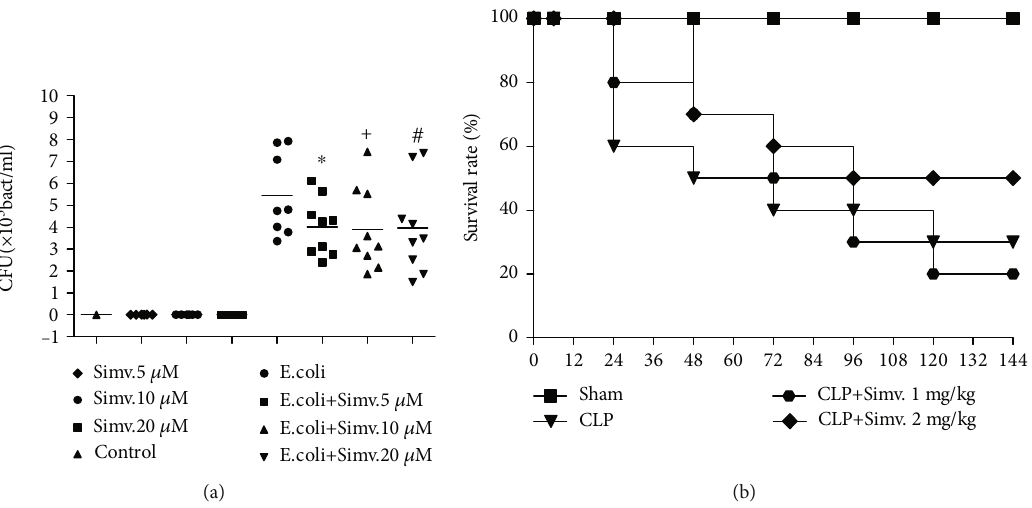
Figure 9: E ff ect of simvastatin in bacterial elimination by peritoneal macrophages stimulated with E. coli and on mortality of animals submitted to CLP. Peritoneal macrophages were pretreated with simvastatin (5 μ M, 10 μ M, 20 μ M), and after 1 hour, they were stimulated with E. coli (a). After 30 minutes, the culture supernatants were plated for CFU counting. SW mice were treated with simvastatin (1 mg/kg and 2 mg/kg) 6 hours after surgery. The mortality was observed for 7 days after sepsis induction (b). Data represented as mean ± SEM of at least 6 animals. ∗ p < 0 : 05 , control vs. CLP+vehicle, # p < 0 : 05 , CLP+ vehicle vs.